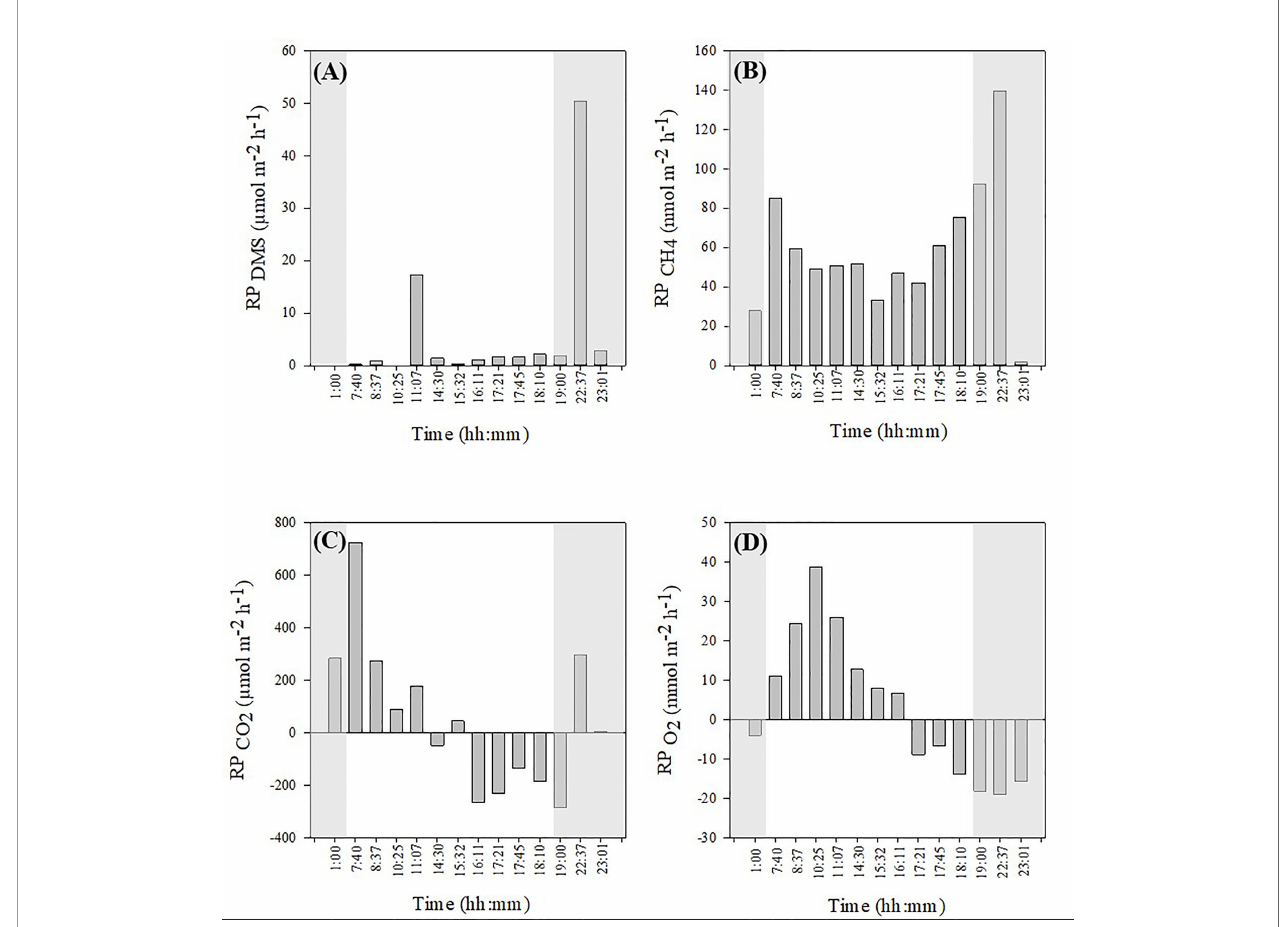
FIGURE 4 | 24h-integrated reef production (RP) for DMS (A) , CH 4 (B) , CO 2 (C) and O 2 (D) calculated around each low-tide period. Shaded areas represent hours of